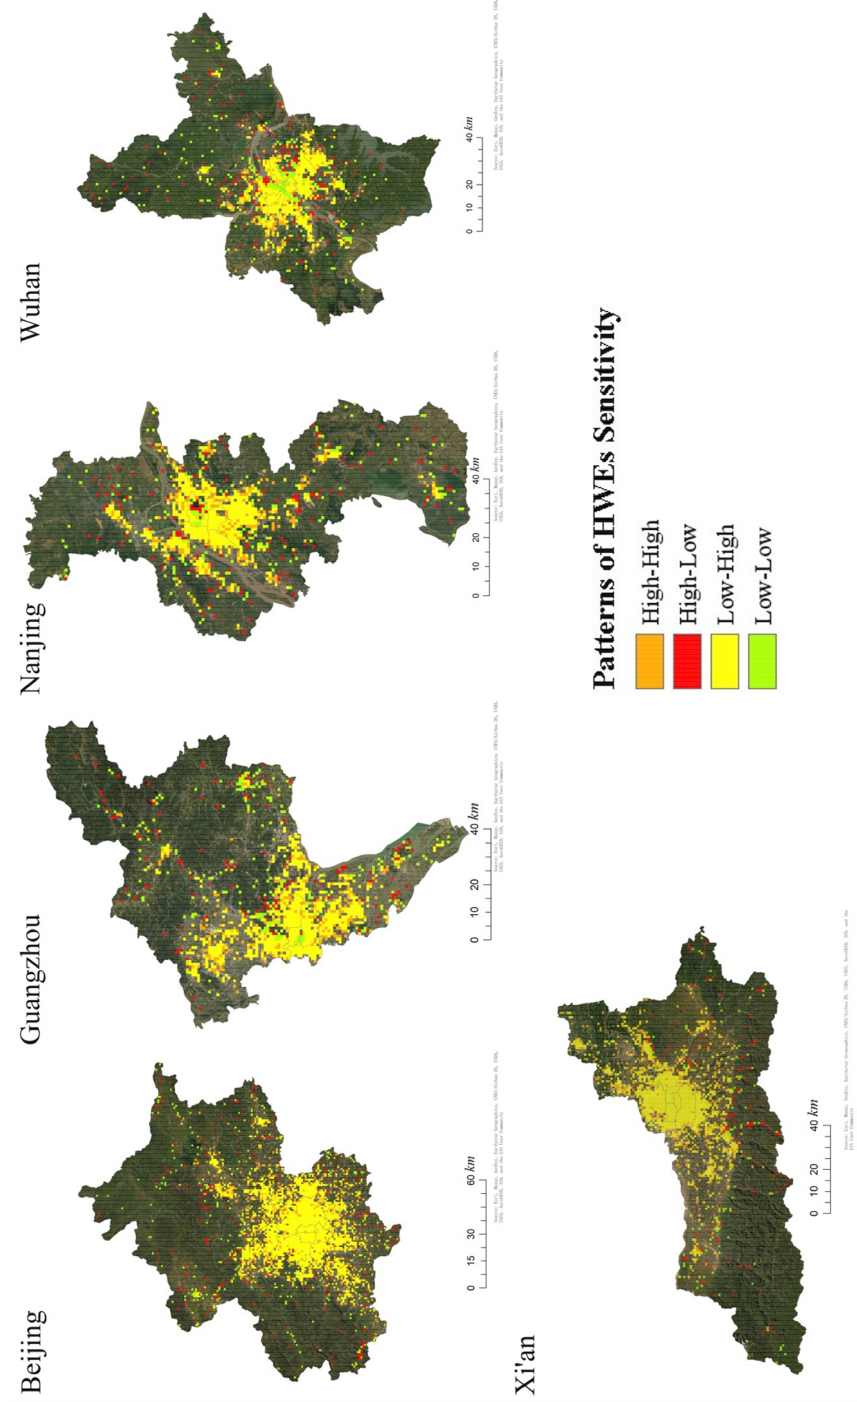
Figure 6. Different types of urban residential sensitivity to heatwaves in the study